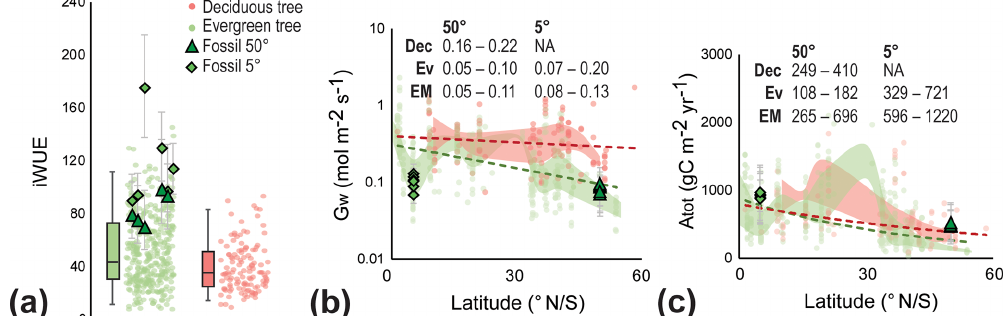
Figure 5. Early Miocene leaf-level physiological parameters of canopy trees. (a) Intrinsic water-use efficiency (iWUE) of evergreen (green circles) and deciduous trees (red circles) based on modern leaf-level measurements (Maire et al., 2015) and fossil reconstructions (green triangles and diamonds). Error bars on fossil-derived data indicate ± 1 σ ; box-and-whisker plots indicate the median, first, and third quartile ( Q 1 and Q 3 ) and 95% confidence interval of modern leaves of canopy trees. Individual data points are randomized on the x axis for a clearer depiction of the distribution. (b) Conductance to water ( G w ) from modern evergreen (Ev) and deciduous (Dec) trees (Maire et al., 2015) and early Miocene fossils (EM) from different latitudes. The shaded red and green areas indicate the Q 1 – Q 3 range of modern evergreen and deciduous trees, respectively, and the dashed lines indicate the overall linear trend with latitude. Text in panel is the Q 1 – Q 3 range for each group, grouped in 5 ◦ latitude bins. (c) Total annual carbon flux per unit leaf area ( A tot ) from modern evergreen (Ev) and deciduous (Dec) trees (Maire et al., 2015) and fossils (EM) from different latitudes. The shaded red and green areas indicate the Q 1 – Q 3 range of modern evergreen and deciduous trees, respectively, and the dashed lines indicate the overall exponential trend with latitude. Text in panel is the Q 1 – Q 3 range for each group, grouped in 5 ◦ latitude